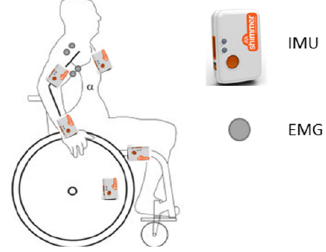
Figure 1. The instrumentation and placement. A manual wheelchair (Küschall Compact, seat width 46 cm, 3° camber, Küschall AG,